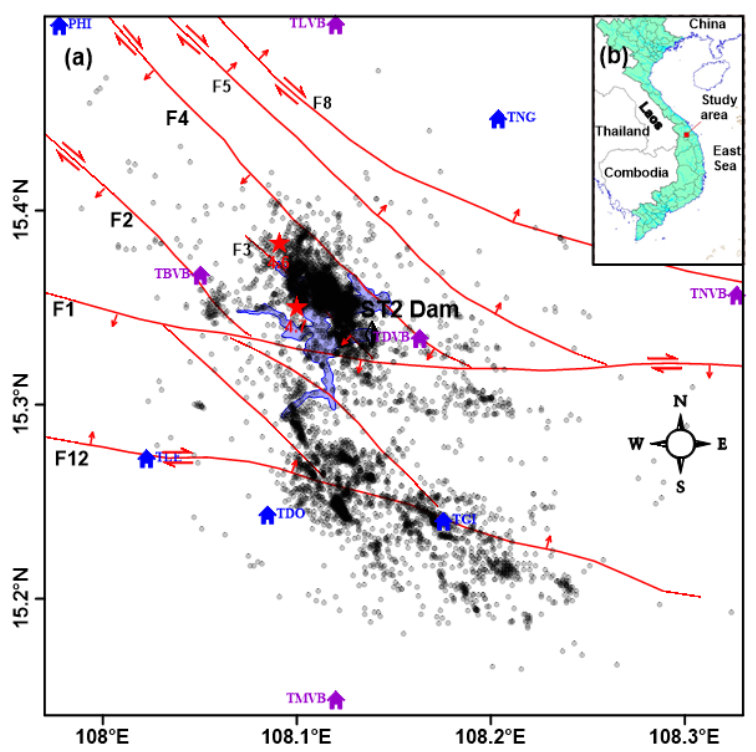
Figure 1. ( a ) Spatial distribution of earthquake epicenters during the period of September 2012 to March 2020 (dark circles) near the Song Tranh 2 reservoir (light blue). The investigation area, represented by the red square in the inner map ( b ), is located in the center of Vietnam. The earthquakes with ML 4.7 and 4.6 are indicated by red stars. Geology and identified geologically mapped faults (red) with dip and slip direction as given by Hoai et al. [22,23].